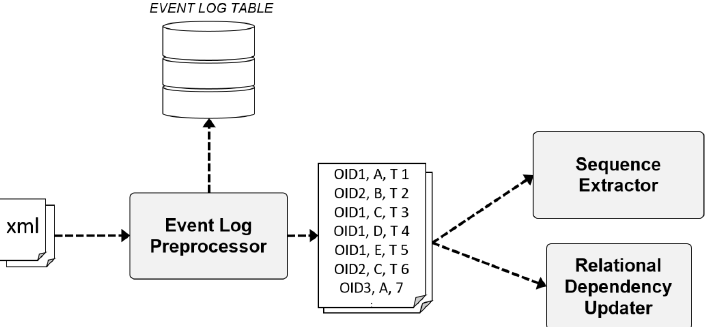
Figure 8. Examples of input and output data for the Event Log Preprocessor process.